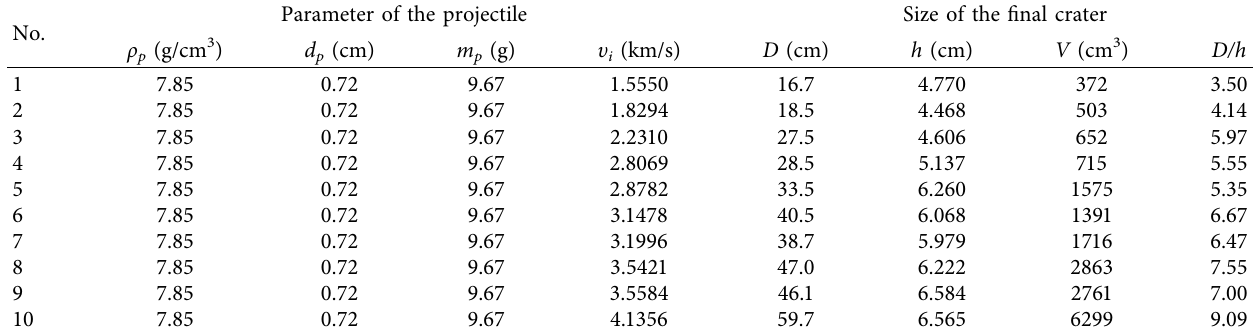
Figure 8: Cratering test on granite under hypervelocity projectile impact. (a) Photograph of a crater. (b) 3D scanned image of the crater. (c) Crater profile. Table 1: Experimental results of the final